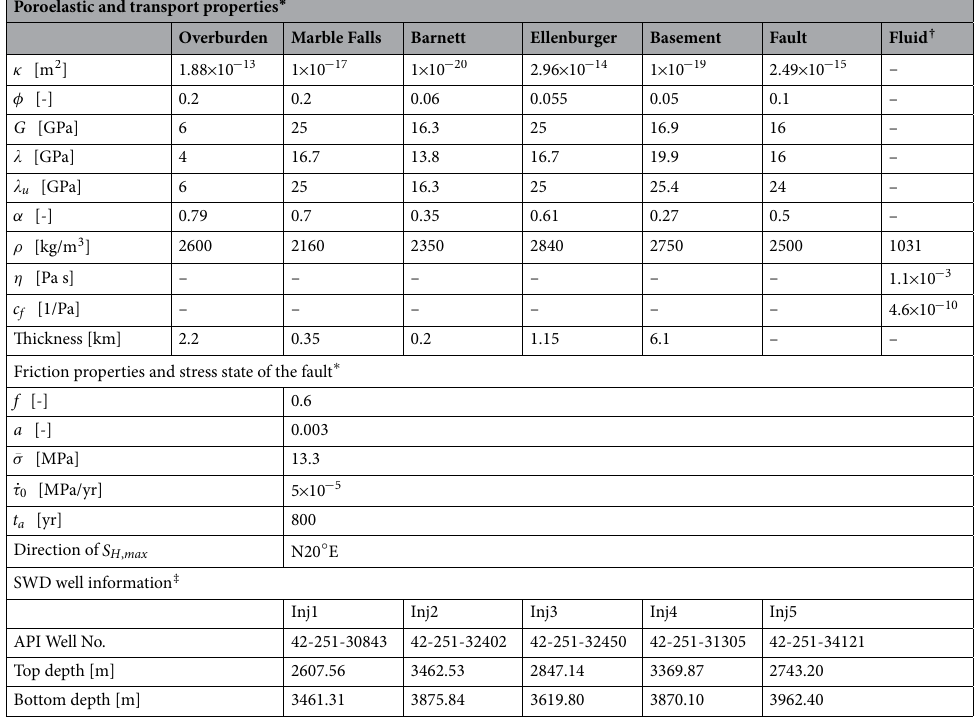
Table 2. Parameters used in the field-scale model for Venus earthquakes. properties of formation and fault from previous studies of Azle earthquakes 5,60 . † Fluid properites are from 64 . ‡ Refer to 29